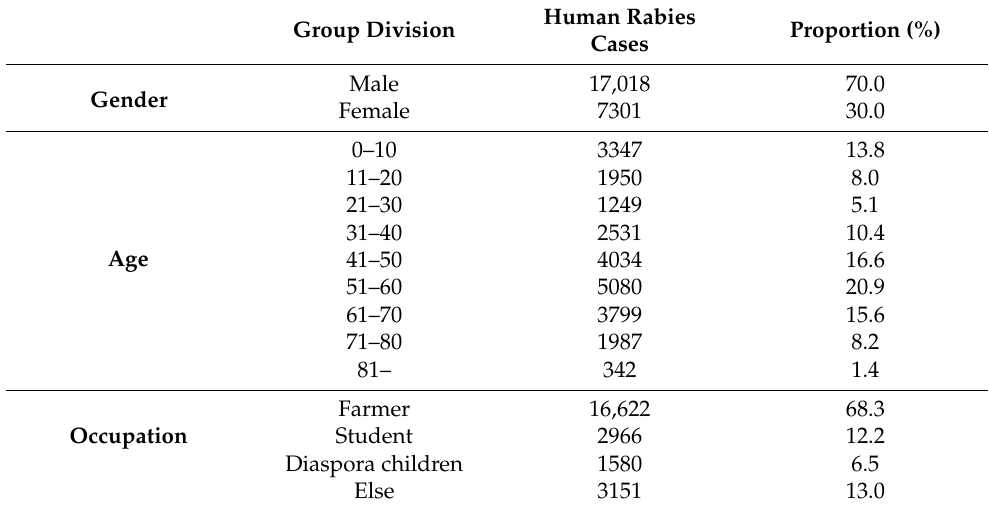
Table 1. Demographic analysis for human